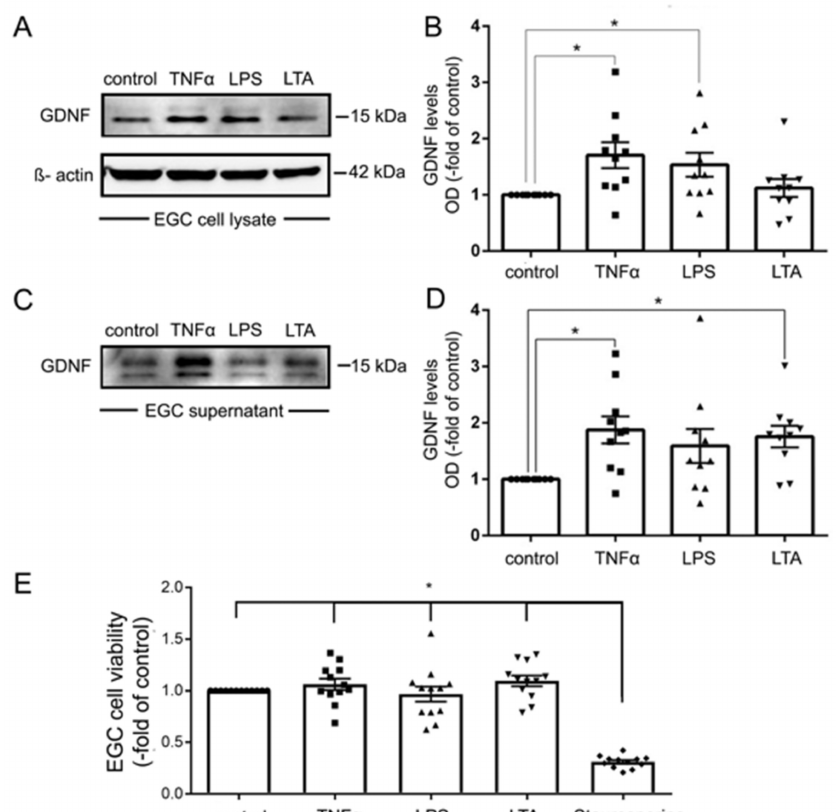
Figure 7. Tumor necrosis factor α (TNF α ) increased the expression and secretion of glial cell line-derived neurotrophic factor (GDNF) in enteric glial cells (EGC). ( A ). Representative Western blot of EGC cell lysates showing that TNF α and lipopolysaccharide (LPS) but not lipoteichoic acid (LTA) led to increased expression of GDNF, membranes were reprobed for β -actin to ensure equal protein loading; ( n = 9). ( B ). Quantification of all Western blots showed a significantly increased expression of GDNF by TNF α and LPS but not by LTA; ( n = 9; * = p < 0.05, Kruskal Wallis Test); Control = Caco2 monolayer without treatment. ( C ). Representative Western blot of EGC cell culture supernatants is shown which demonstrates increased release of GDNF by TNF α and LTA but not LPS; ( n = 9). ( D ). Quantification of all Western blots showed a significantly increased release of GDNF by TNF α and LTA but not by LPS ( n = 9; * = p < 0.05, Kruskal Wallis Test); Control = Caco2 supernatant without treatment. ( E ). MTT assays served to test for cell viability. Except for incubation with staurosporine EGC cell viability was not changed for the different experimental conditions ( n = 10; * = p < 0.05 control, TNF α , LPS, LTA vs. Strauosporine; Kruskal Wallis Test); Control = Caco2 monolayer without